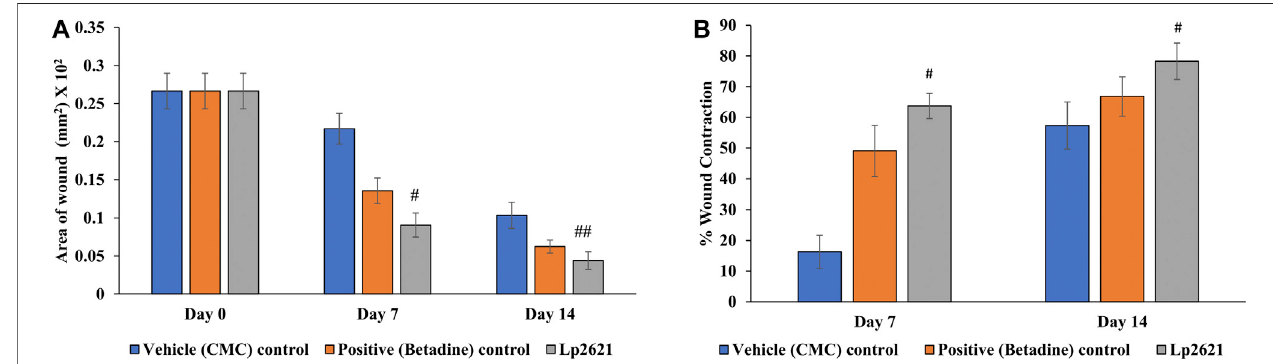
FIGURE11| EffectoftopicaltreatmentofLp2621gelondifferentgroups: (A) onwoundareainfectedwithS. aureus and (B) percentwoundcontractionatdifferent days post-wounding. Data are expressed as mean ± SD. # , and ## mean p (cid:1) 0.002, and p (cid:1) 0.020.